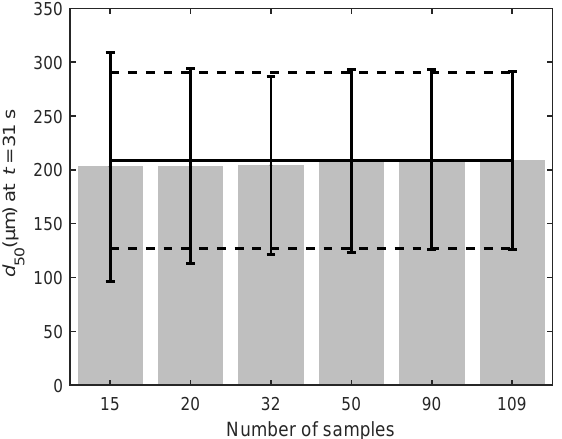
Figure 9. The number of samples used for PCE2 approximation based on the d 50 value at 31